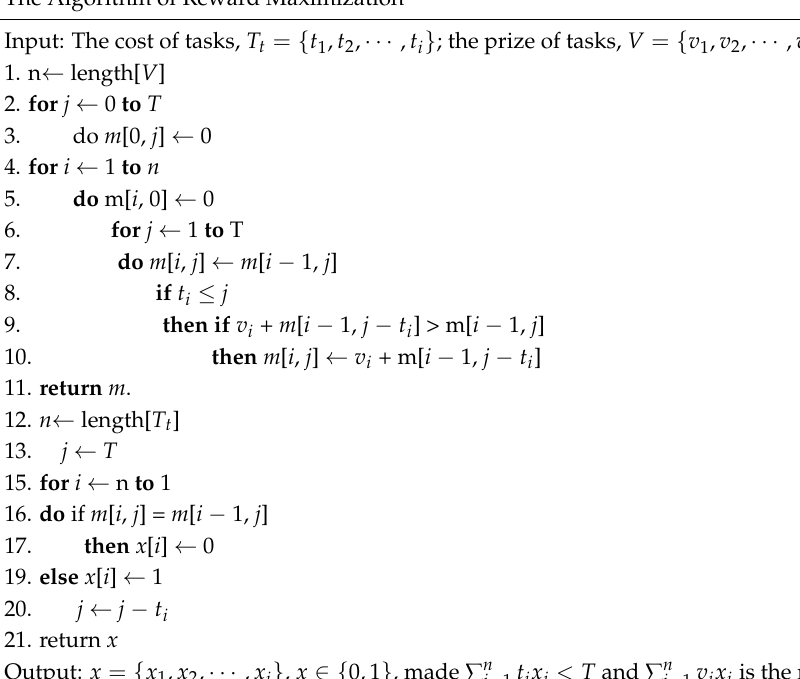
The Algorithm of Reward